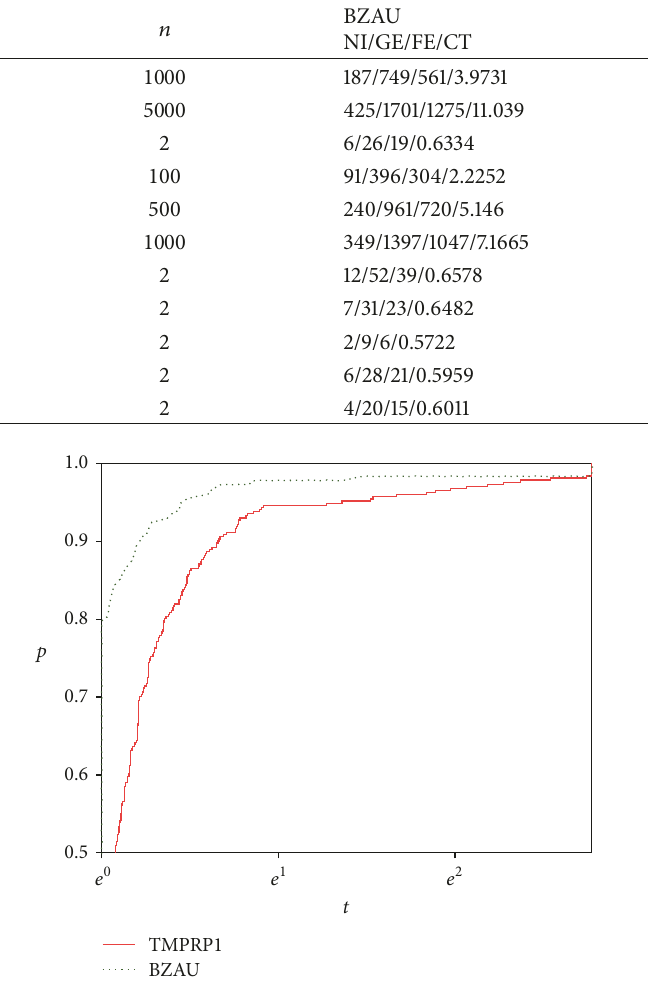
Figure 3: Performance profiles based on number of gradient evaluations.